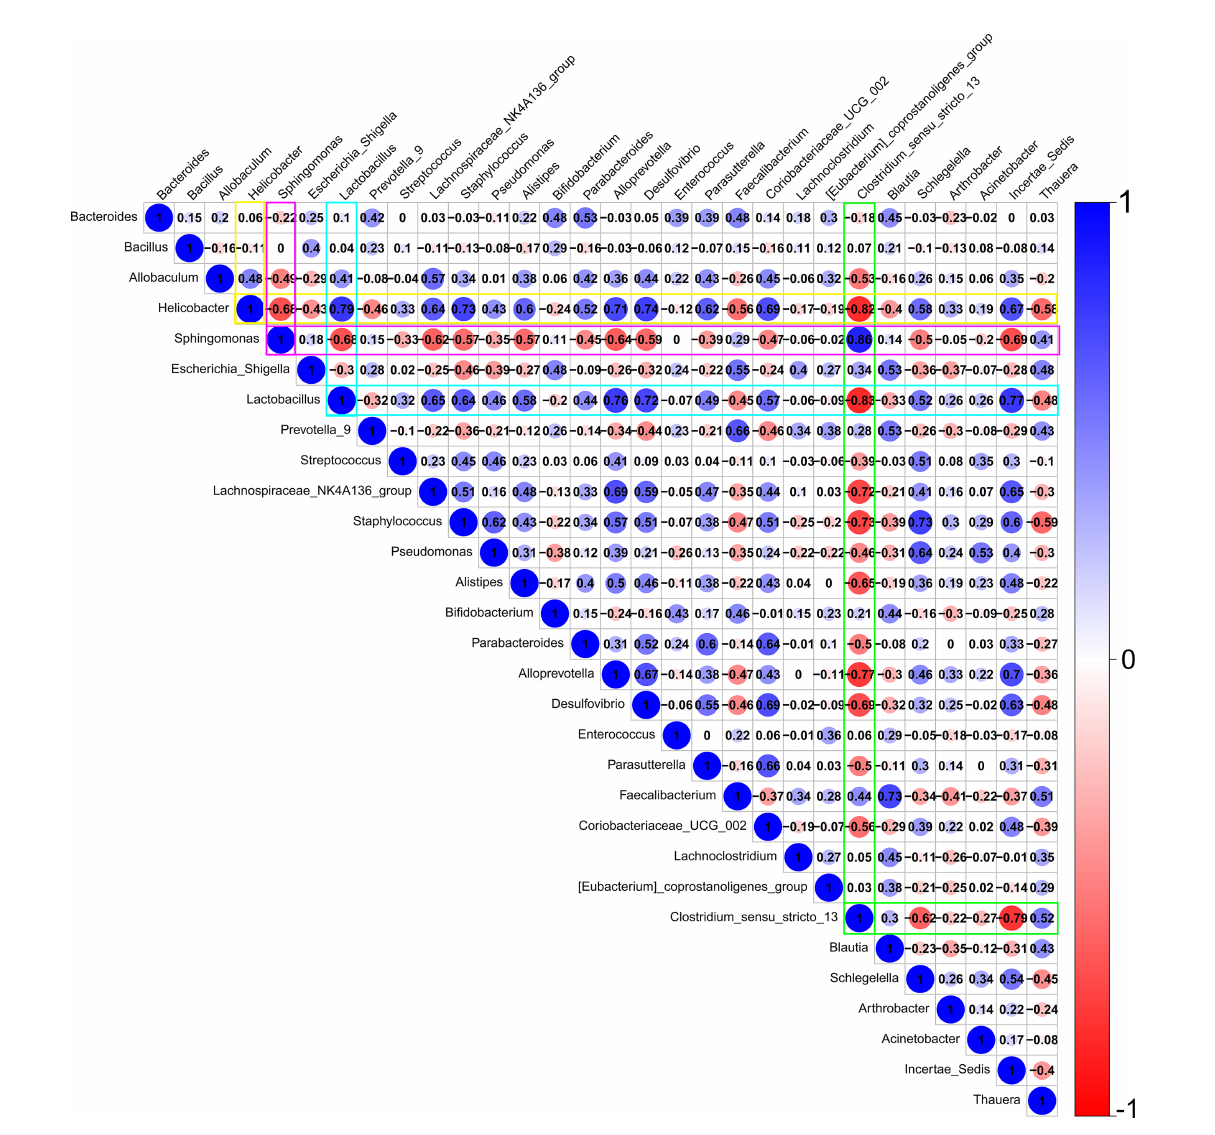
FIGURE 5 | A predicted interaction network of the top 30 bacterial genera was established based on Spearman correlation coef fi cients. Red represents a negative correlation, and blue represents a positive correlation. Darker color, larger circle, and larger number represent a stronger correlation. Lactobacillus , Clostridium , Helicobacter , and Sphingomonas are speculated to have signi fi cant relatedness (|SpearmanCoef|> 0.8 and p <0.01) in the interaction network of the conjunctival bacterial microbiome. Lactobacillus may have an antagonistic effect on Clostridium . Helicobacter may have a synergistic effect on Lactobacillus